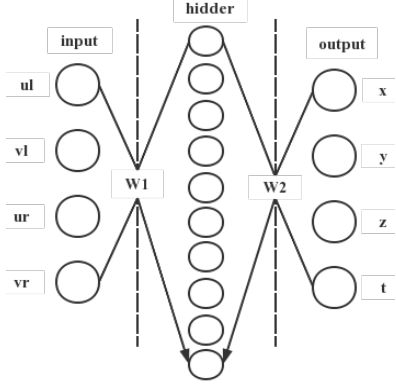
Figure 2. The 4 - 10 - 4 type BP network. Figure 2. The 4-10-4 type BP